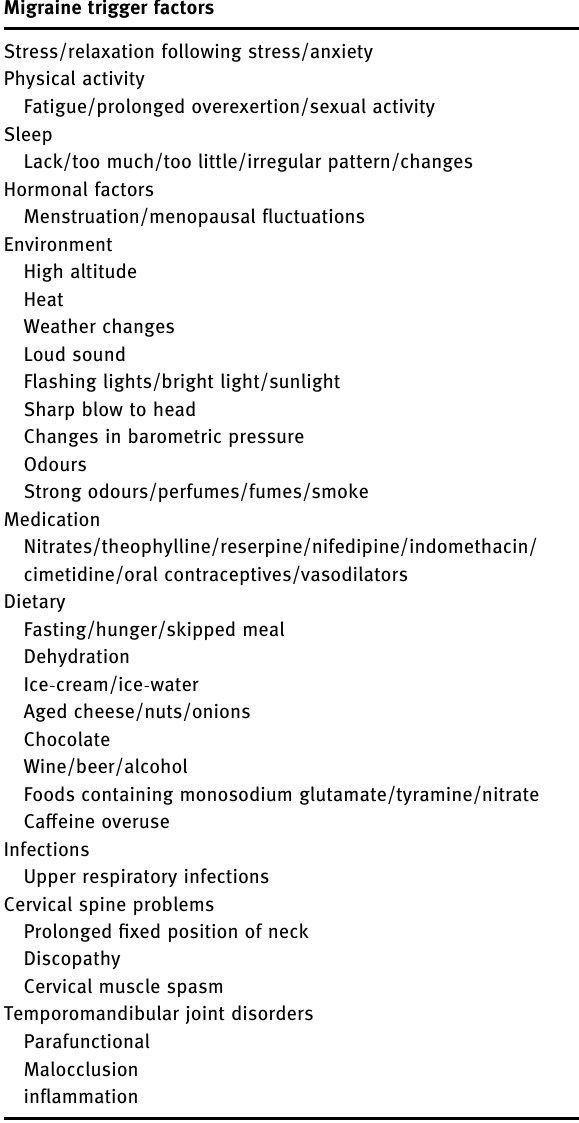
Table 2: Common migraine trigger factors Migraine trigger factors Stress/relaxation following stress/anxiety Physical